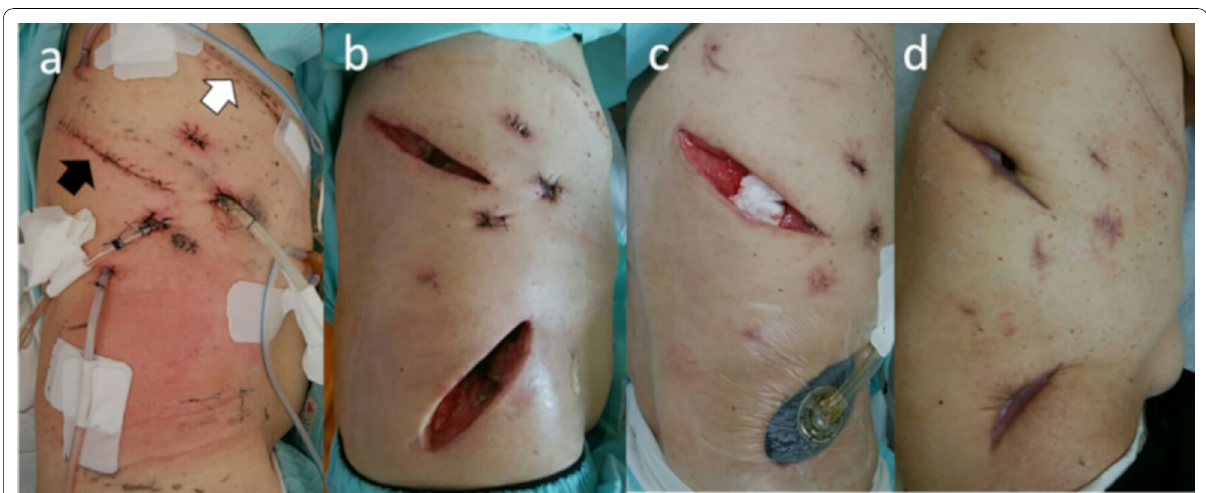
Fig. 1 Appearance of the wound. a Just before the second emergency surgery. Redness can be observed at a considerable distance from the initial lobectomy wound (white arrow) or the first emergency open debridement wound (black arrow). b One month after the initial surgery. c The chest wound is treated with gauze exchange and washing, and the buttock wound was treated with negative‑pressure therapy. d Four months after the initial surgery. The wound is completely closed without fistula